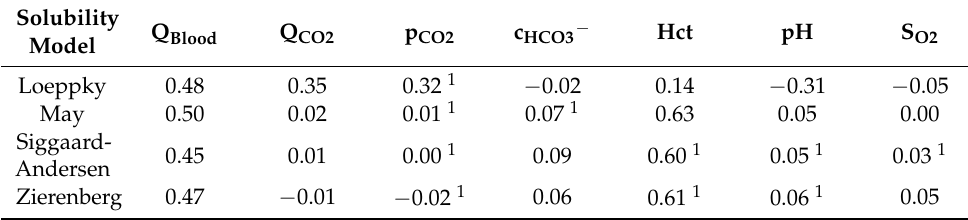
Table 3. Spearman correlation coefficients between average prediction error ( ε ) and selected parame- ters calculated for in vivo porcine blood trials and the four CO 2 solubility models.